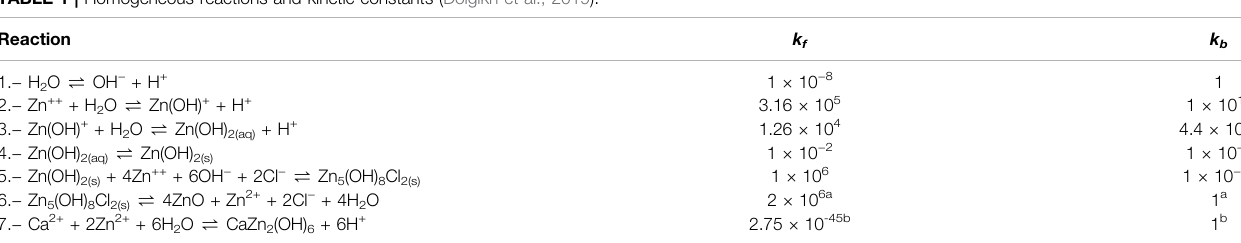
TABLE 1 | Homogeneous reactions and kinetic constants (Dolgikh et al., 2019). Reaction